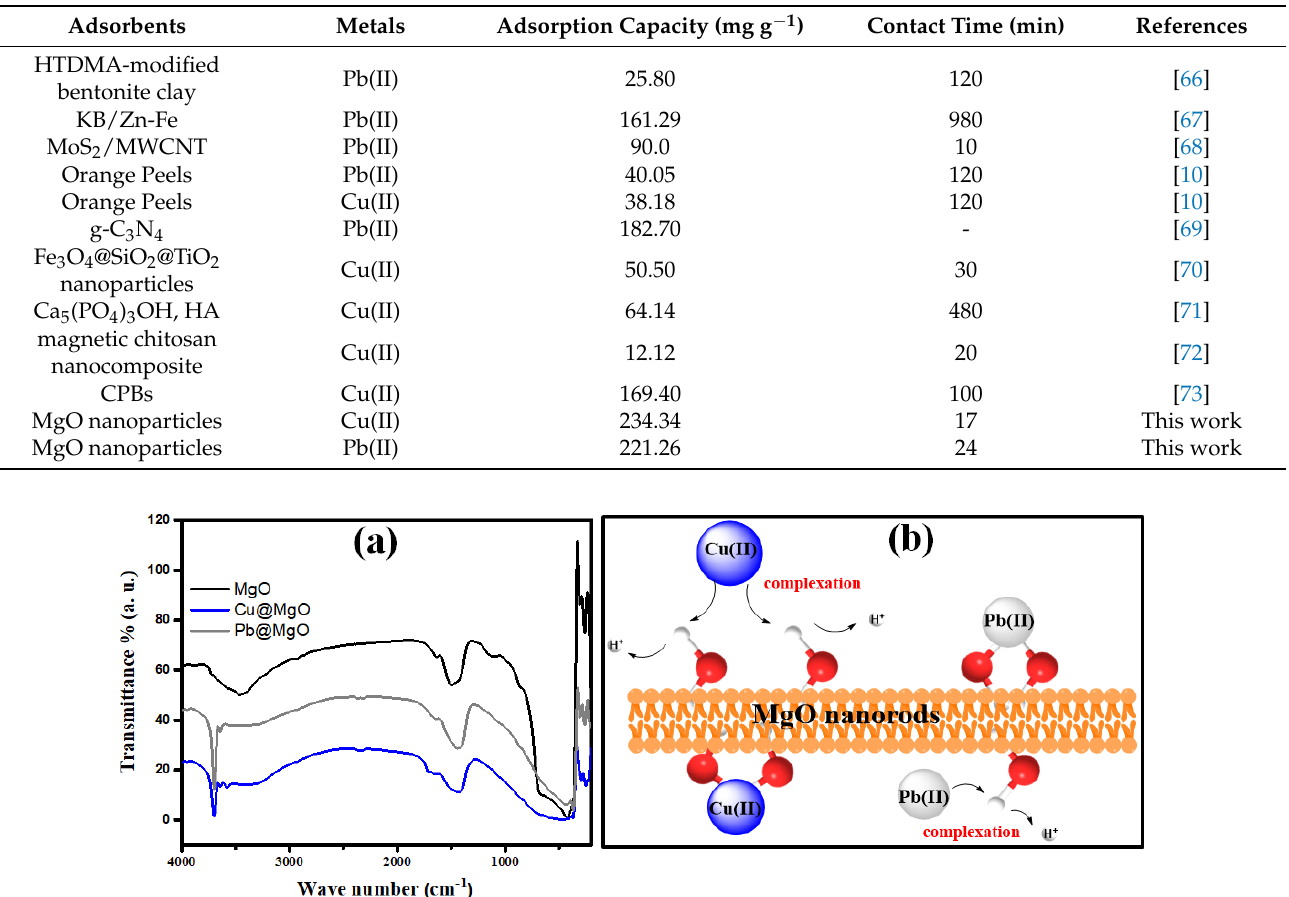
Figure 9. MgO nanorods recyclability. 4. Conclusions In this study, MgO nanorods were effectively produced using a simple coprecipita- tion method. SEM analyses revealed that the MgO nanoparticles exhibit a homogeneous structure resembling a rod. The application of MgO nanorods for simultaneous removal of Cu(II) and Pb(II) from aqueous solutions was scrutinized. Several adsorption factors, including contact time, starting heavy metals concentration, interfering ions, and pH, were also investigated. The MgO nanorods present higher adsorption capacities towards Cu(II) (234.34 mg/g) and Pb(II) (221.26 mg/g) at pH values equal to 3. The elimination of Pb(II) and Cu(II) by nanocomposite reached equilibrium within 17–24 min. It was deter- mined that the Langmuir isotherm and PSO kinetic model best fit the adsorption process, suggesting a monolayer chemisorption process. The regeneration experiments demon- strate the potential applicability of MgO nanorods for the elimination of Pb(II) and Cu(II)